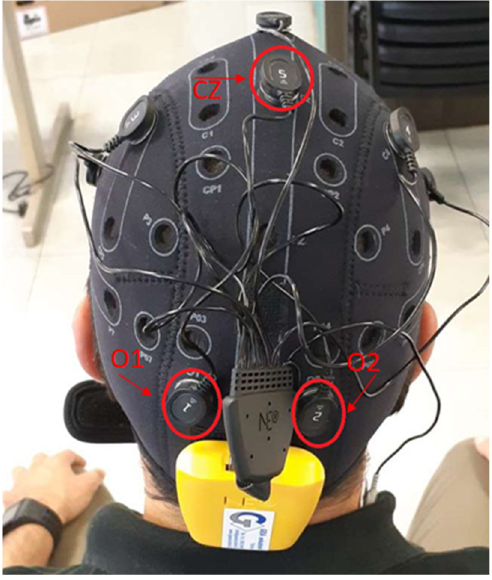
Figure 3. EEG Enobio Cap.